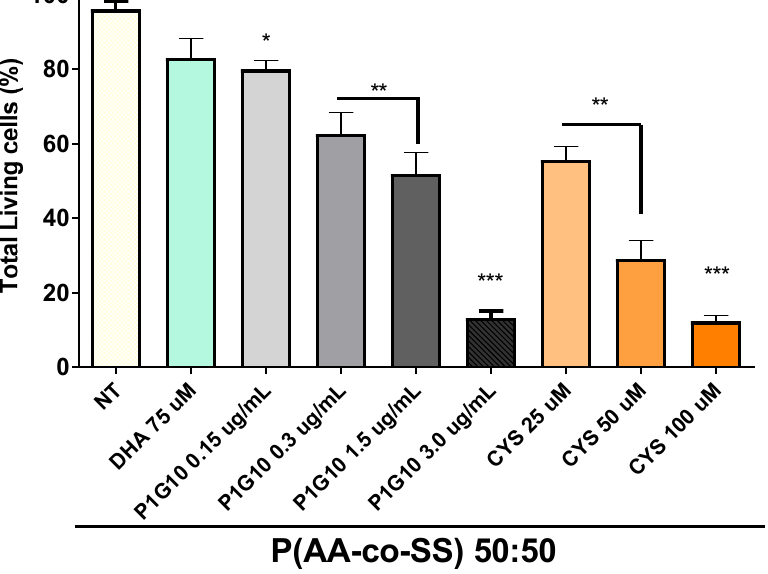
Figure 8. The proliferation rate of human hES cells in the presence of 50:50 P (AA:SS) copolymer mesh charged with 20 µL of CDDP drug. 5 × 10 3 of hES cells were seeded in the center of the mesh, and the proliferation rate was evaluated at 24 h. The graph shows the total living number of hES cells cultured in CDDP at 25 µM, 50 µM and 100 µM, P1G10 at 0.15 µg/mL, 0.3 µg/mL, 1.5 µg/mL and, 3.0 µg/mL and left untreated (NT). Ordinary one-way analysis of variance ANOVA with respect to NT (* p ˂ 0.01, ** p ˂ 0.001, *** p ˂ 0.0001) was used.